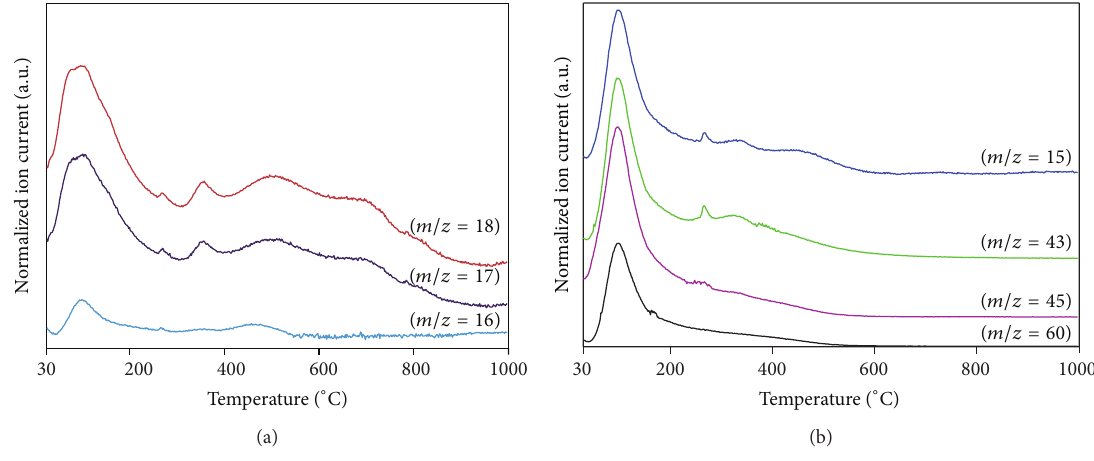
Figure 4: Ion currents in the MS curves, (a) water and (b)